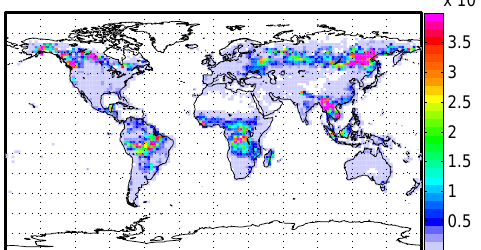
Figure 13. C 2 H 2 and HCN surface emission fluxes (kgm − 2 s − 1 ) averaged over the period 2008–2010 from the anthropogenic and Figure 11. C 2 H 2 and HCN surface emission fluxes (kg m − 2 s − 1 ) fire emissions inventories used in MOZART-4. averaged over the period 2008-2010 from the anthropogenic and fire emissions inventories used in MOZART-4.